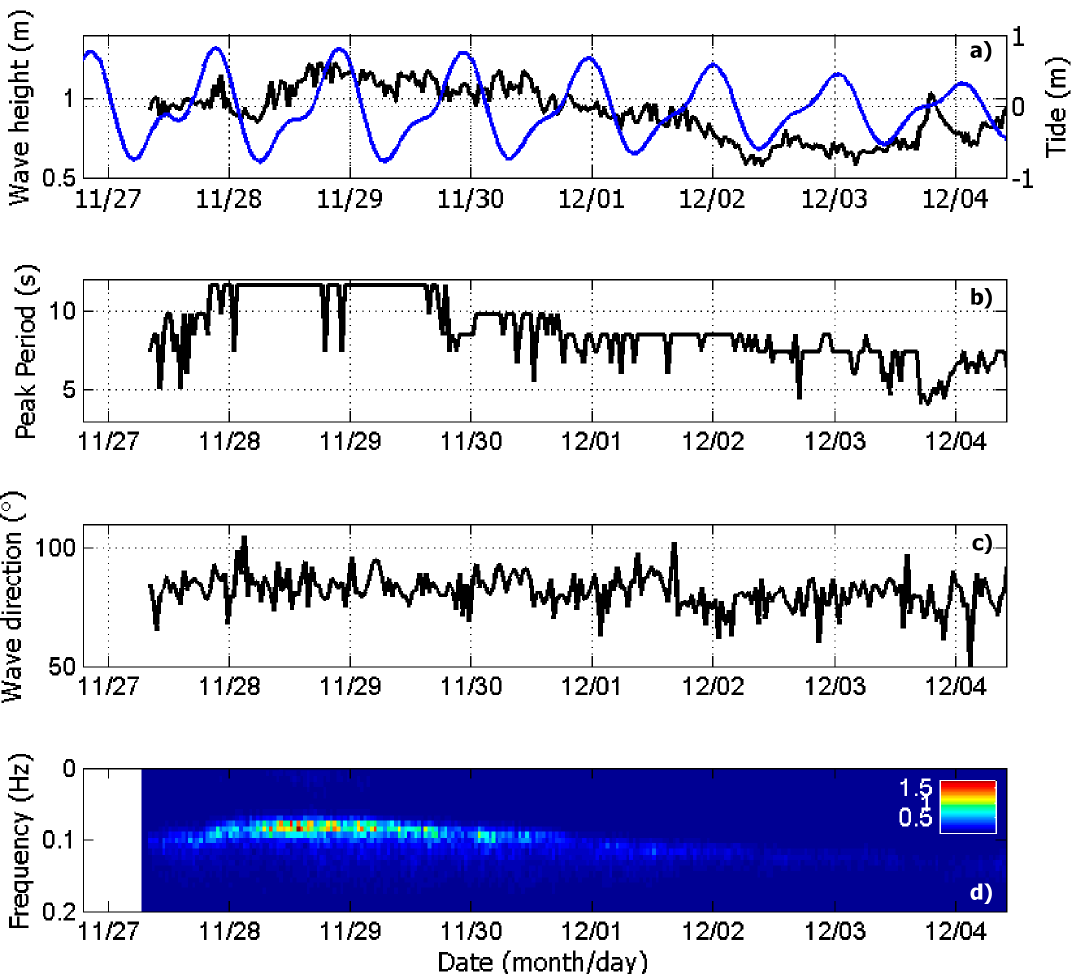
Figure 4. Measurements of tides (blue line) and significant wave height obtained from the ADCP moored off the study site: ( a ) peak wave period, ( b ) mean wave direction, and ( c ) normalized wave spectrum ( d ).